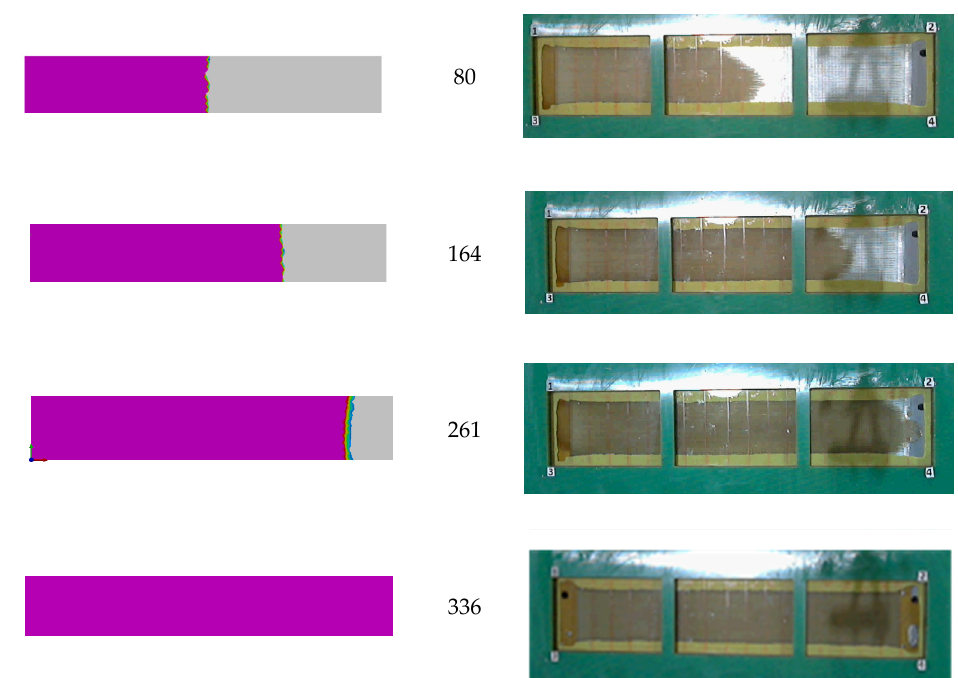
Figure 9. Comparison between simulation and real RTM process with BIO-PUR3 formulation. Table 4. Final properties of BIO-PUR-based